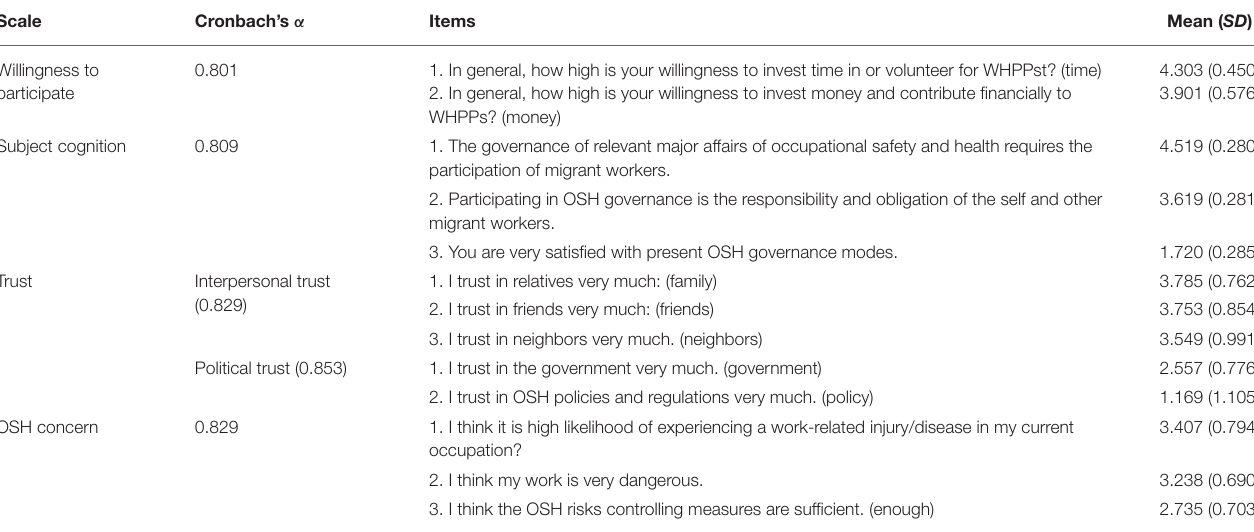
TABLE 2 | Scale, internal consistencies and items for measurement.